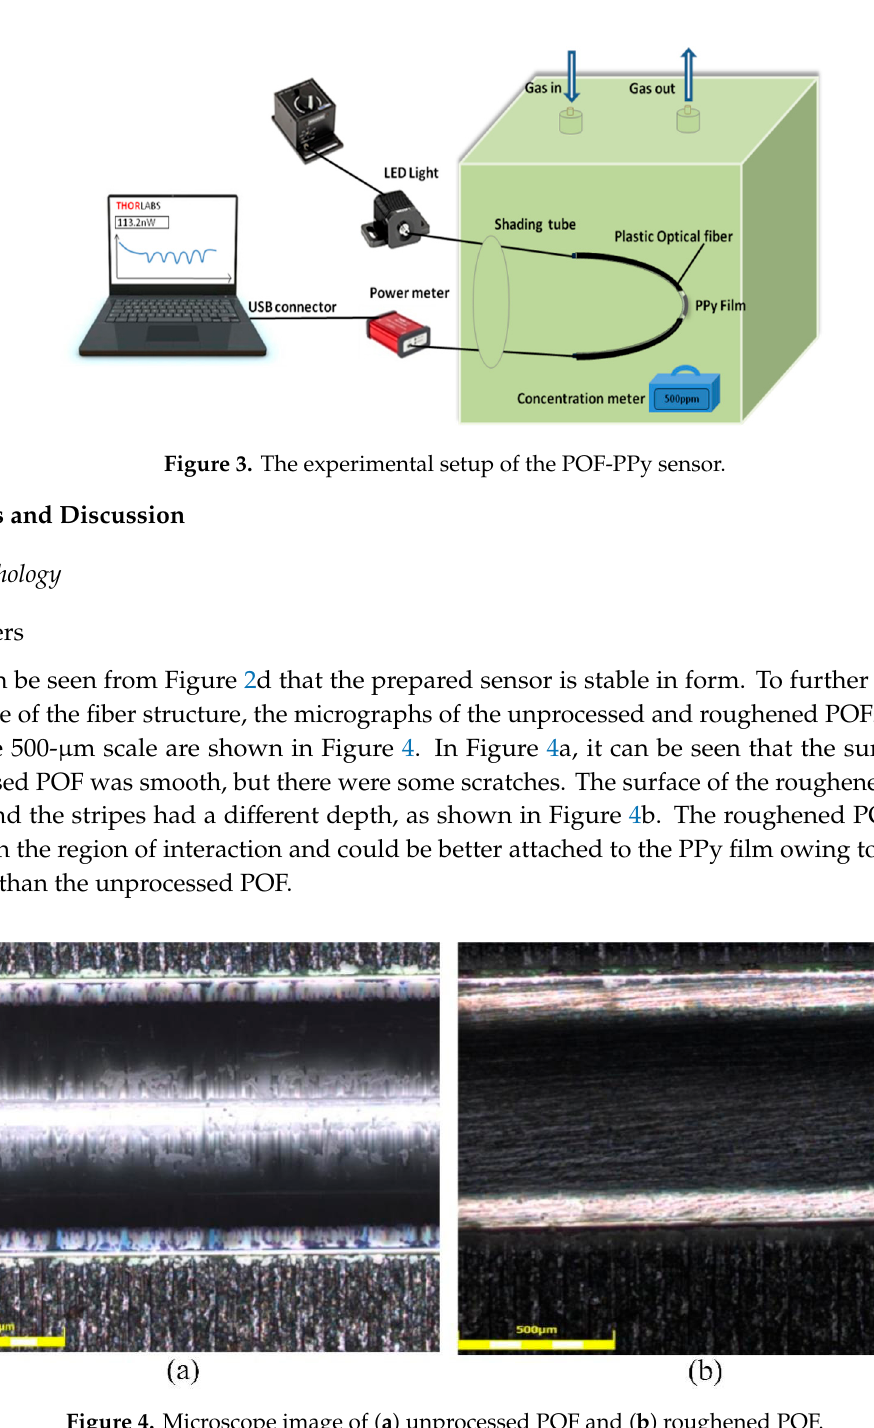
Figure 4. Microscope image of ( a ) unprocessed POF and ( b ) roughened POF.